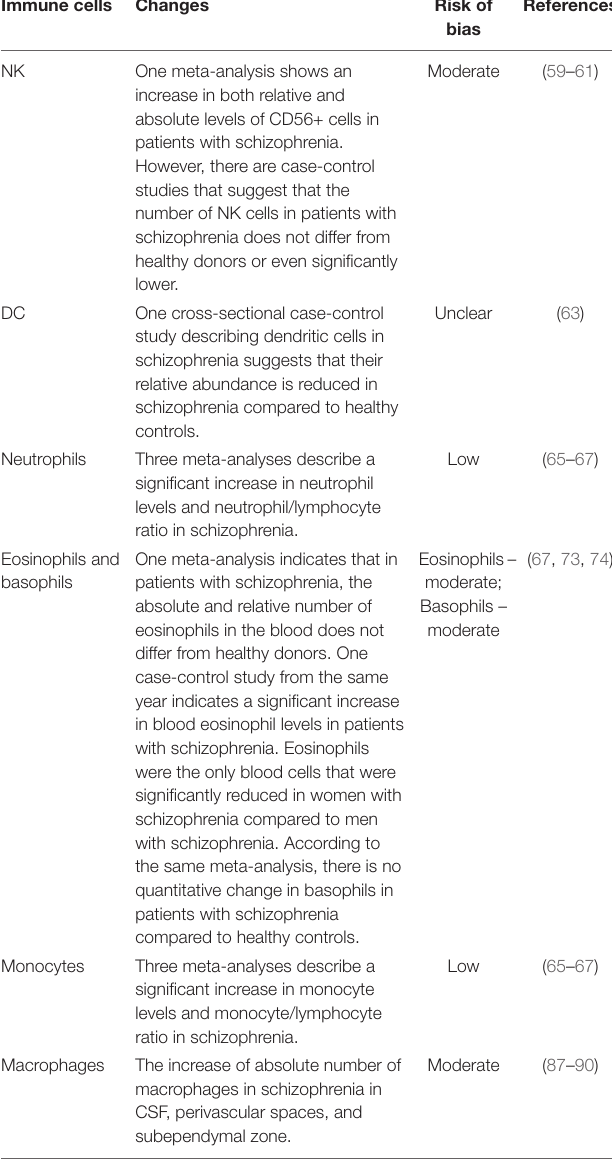
TABLE 3 | Quantitative changes in innate immunity cells in